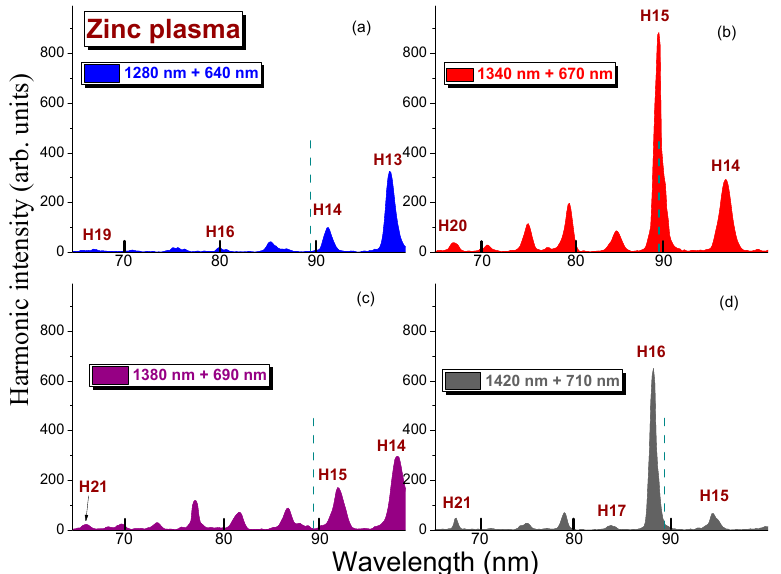
Figure 3. Harmonic spectra obtained during propagation of spectrally tunable pulses through the zinc LIP. A two-color pump (TCP) was used for determination of the resonantly enhanced harmonic orders matching with the wavelength of strong ZnII transition (89.3 nm, dashed line). Four groups of HHG spectra were obtained using ( a ) 1280 nm + 640 nm, ( b ) 1340 nm + 670 nm, ( c ) 1380 nm + 690 nm, and ( d ) 1420 nm + 710 nm pumps. Dashed lines show the position of the 3d 10 4s–3d 9 4s4p transition. H14–H21 correspond to the harmonic orders.